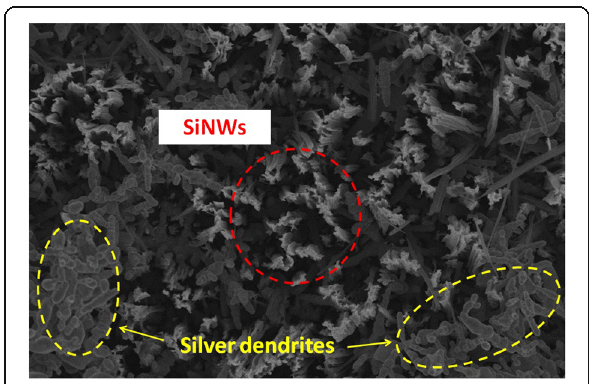
Fig. 2 SEM image showing the formation of SiNWs with silver dendrites after the electroless etching process (before aqua regia